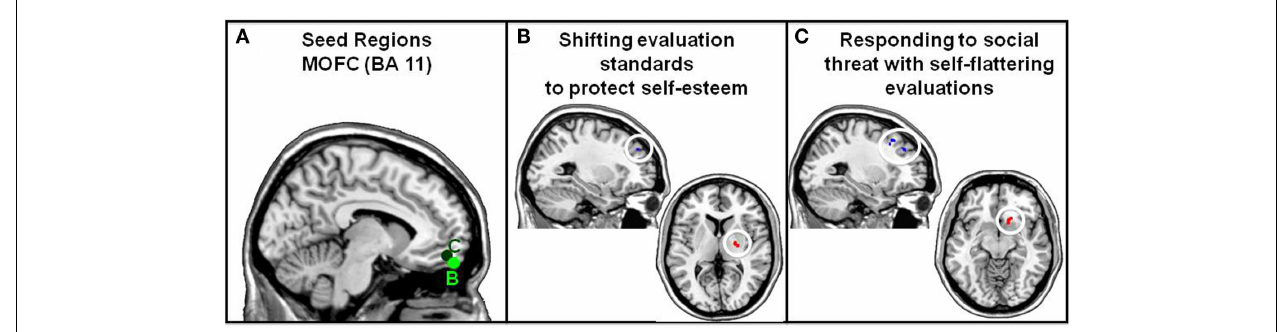
of knowledge could be discovered, the MOFC seed associated with self-protection (i.e., less inflated claims) shows relatively more positive covariation with the right putamen (22, − 10, 6) and less positive covariation with the left middle frontal gyrus (BA 9; − 24, 52, 30). (C) When self-esteem was threatened, the MOFC seed associated with more self-flattering evaluations shows relatively more positive covariation with the right caudate (14, 16, − 10) and less positive covariation with the middle frontal gyrus (BA